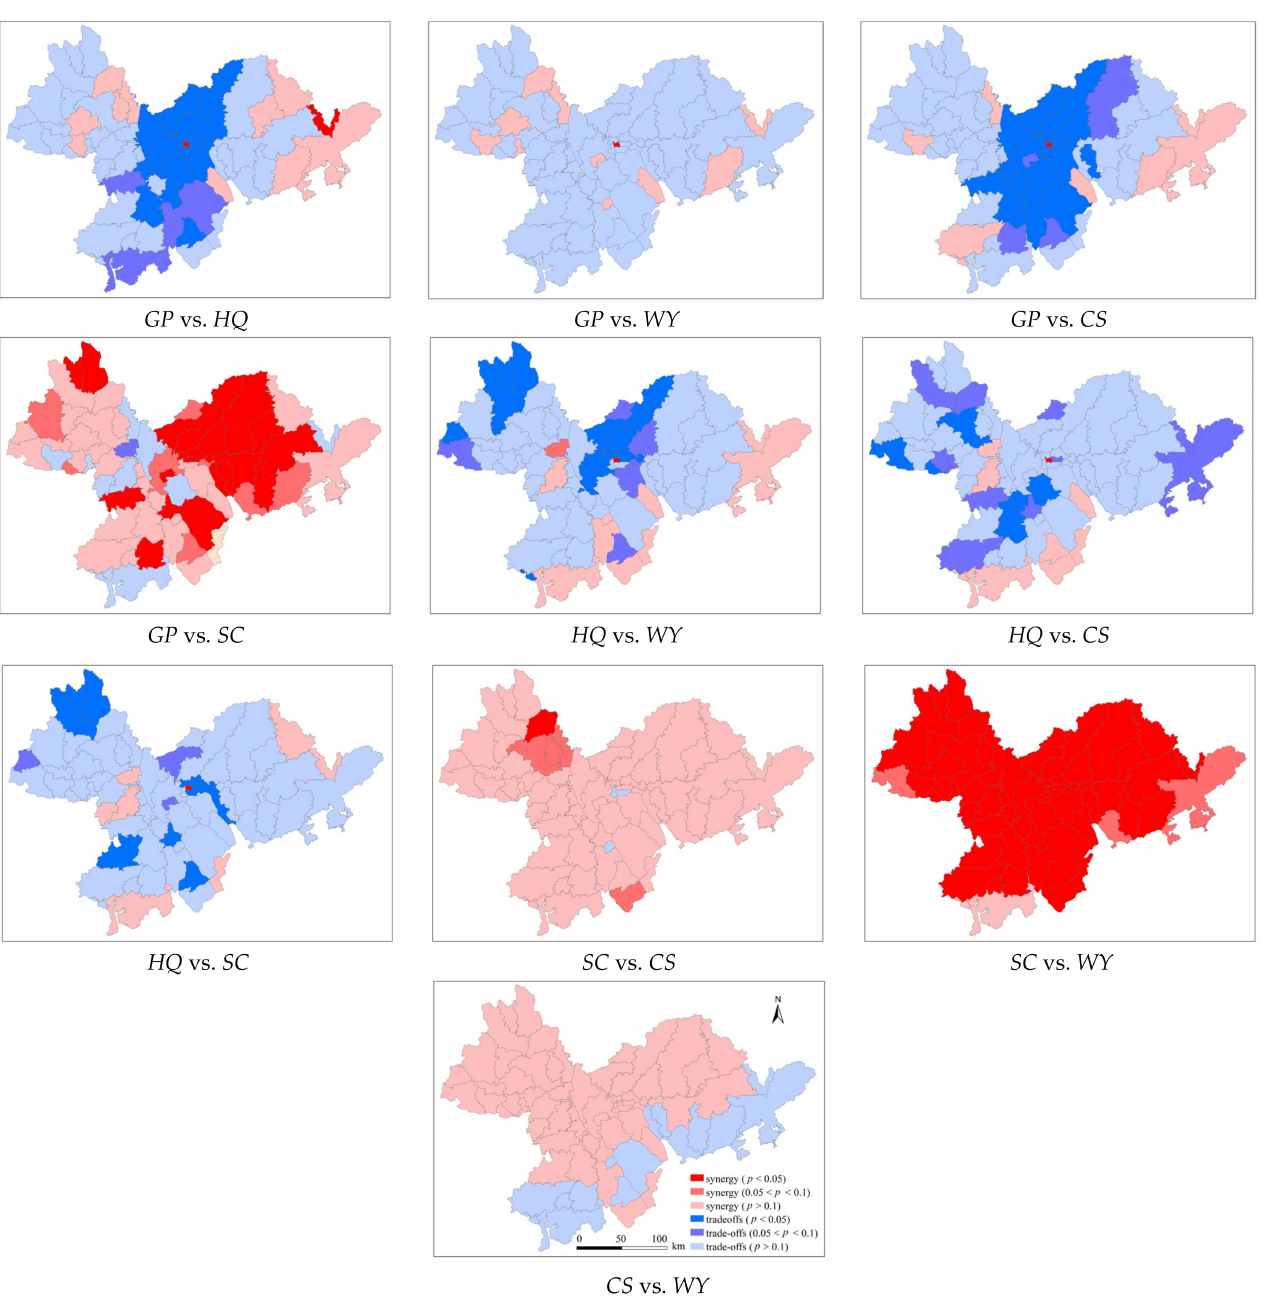
Figure 8. Spatial distribution of the ecosystem services trade-offs/synergies at watershed level in the Pearl River